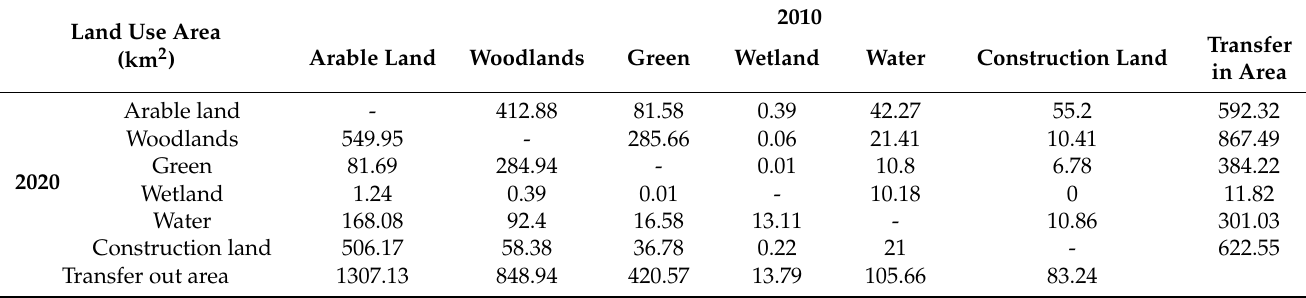
Table 4. Transfer matrix of land use area in urban areas from 2010 to